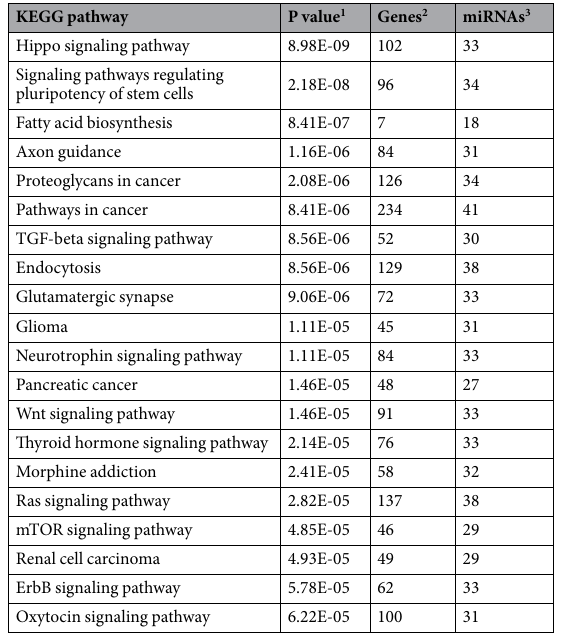
Table 2. Top 20 pathways of target genes from the 48 miRNAs differentially expressed between tumor and healthy tissue of HNSCC patients. 1 Only pathways with P values lower than 0.05 were considered as significant. 2 Number of genes affected in the pathway by the regulated miRNAs. 3 Number of miRNAs differentially expressed that have a target gene in the